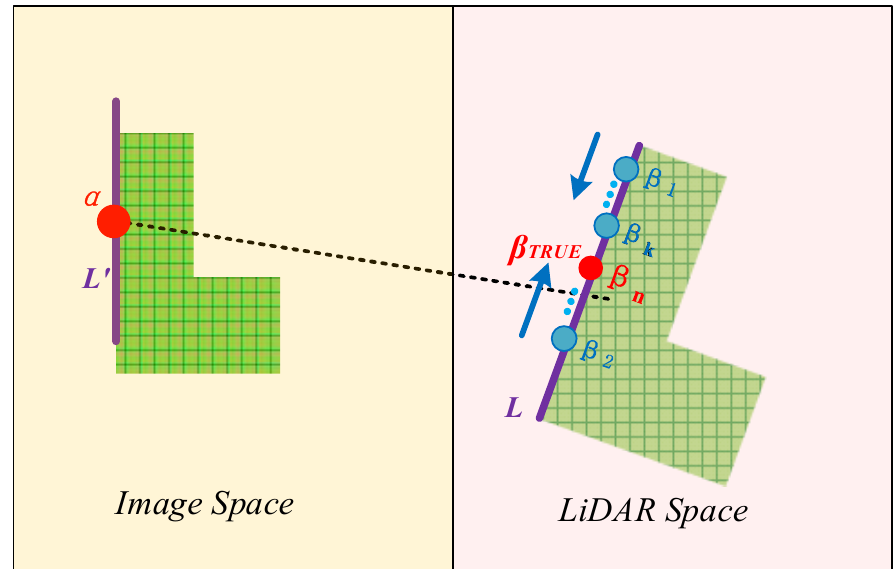
Figure 2. In the iterative process, a point 𝛽 approaches its true position: L ' and L constitute a matched line pair lying on image space and LiDAR space, respectively. The true corresponding point is determined as soon as parameter 𝜆 is calculated in the iterative process.